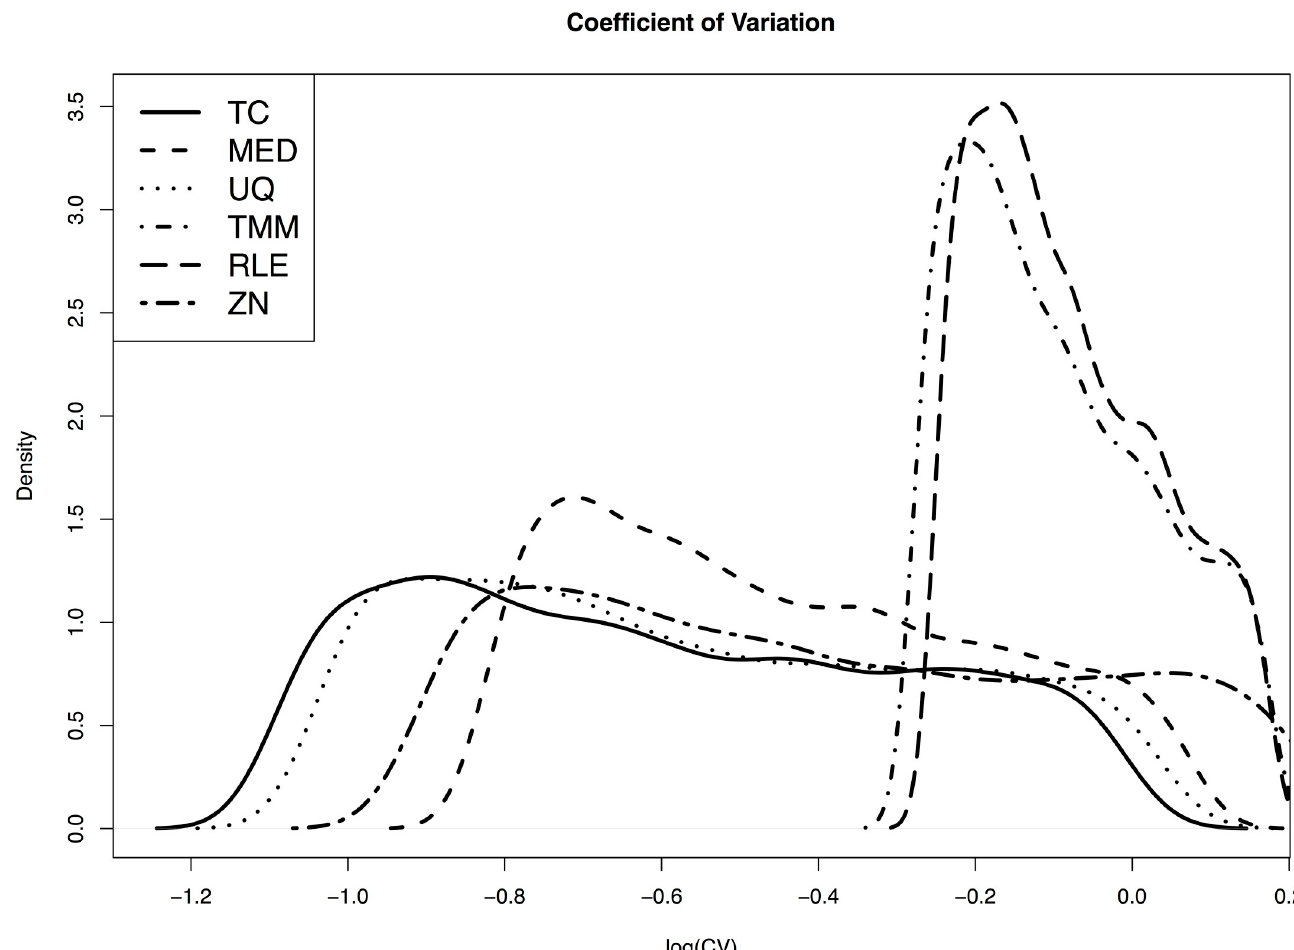
Fig 4. Distributions of coefficient of variations after logarithm